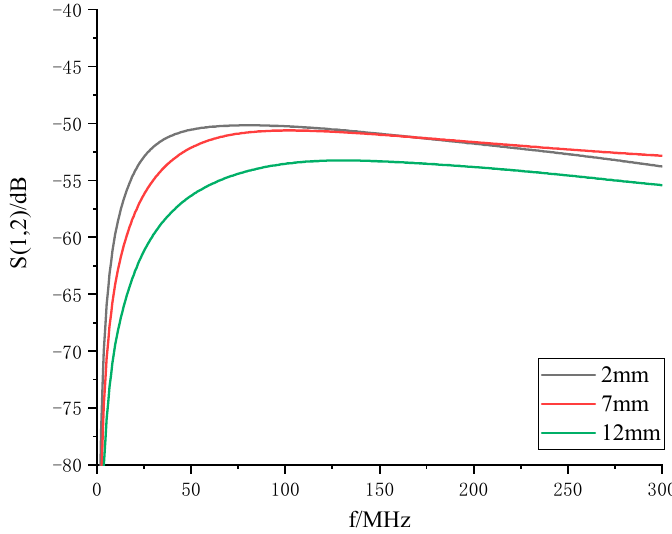
Figure 8. Frequency characteristics of probes with different line radius.